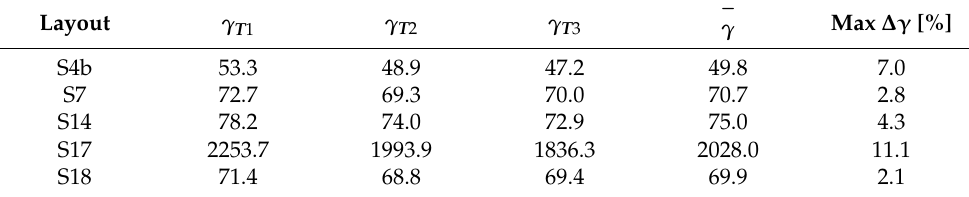
Table 3. Values of γ for the different layouts in three repeated experimental tests. Layout